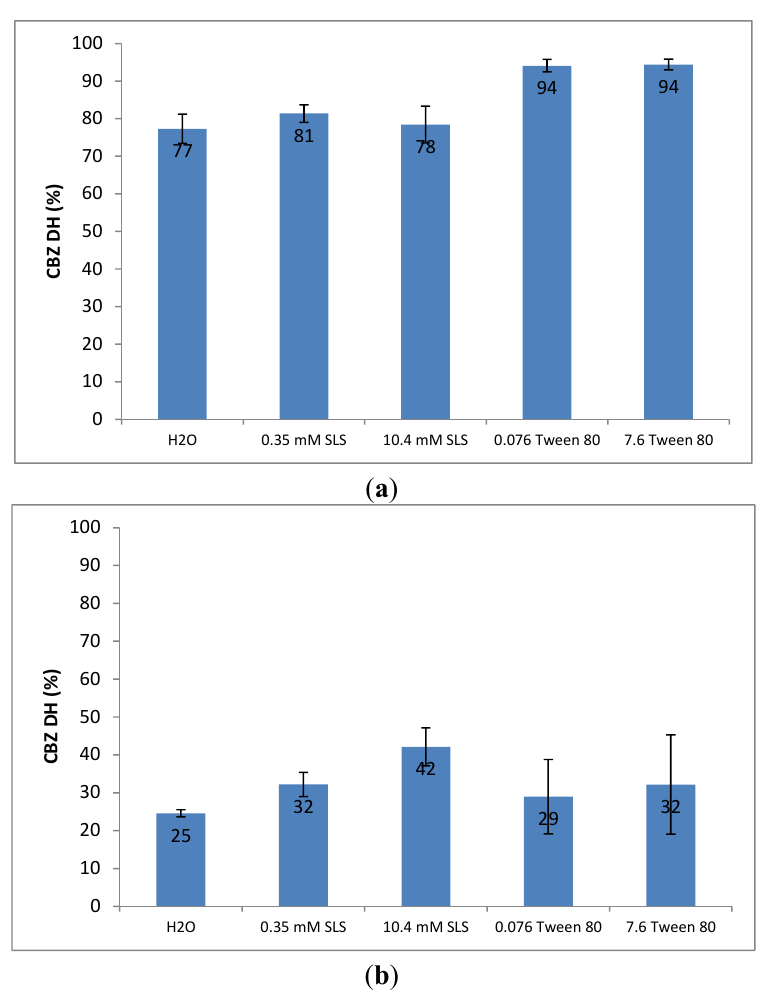
Figure 5. Comparison of percentages of CBZ DH on the surfaces of sample compacts after dissolution test. ( a ) CBZ–NIC cocrystal; ( b ) CBZ